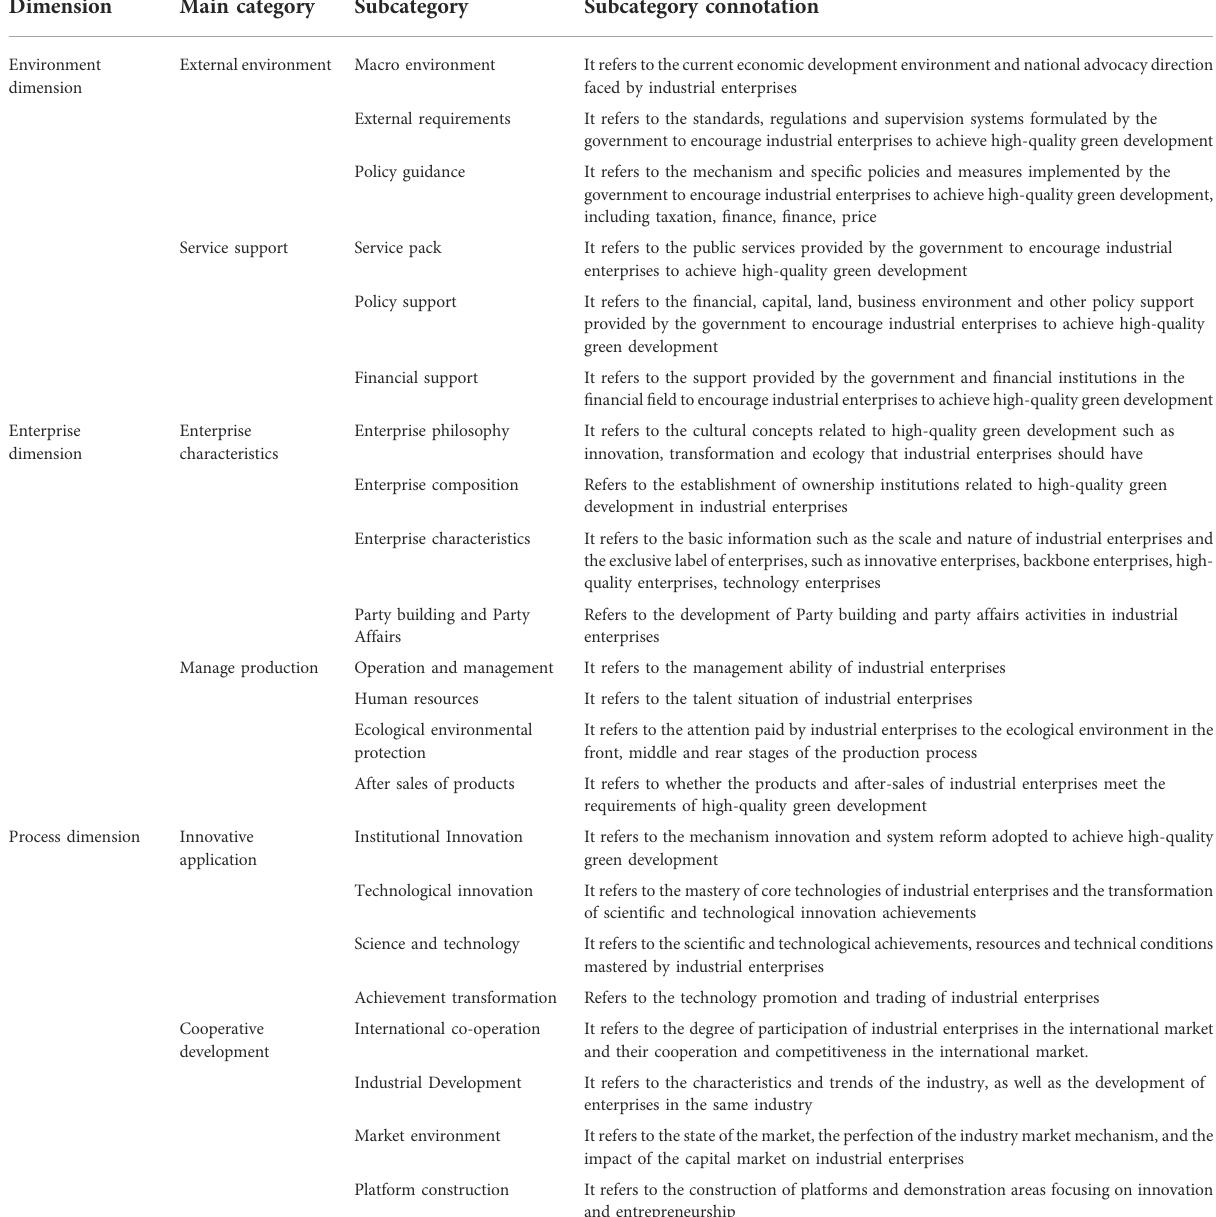
TABLE 5 Spindle coding